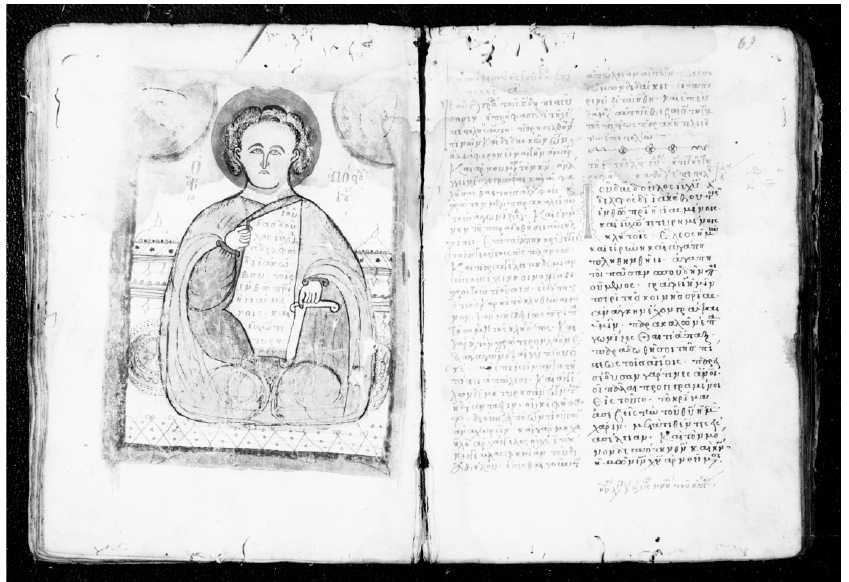
Figure 2. Image of the Apostle Jude. Monastery of the Lavra (Mount Athas) K.190. f. 62v (GA